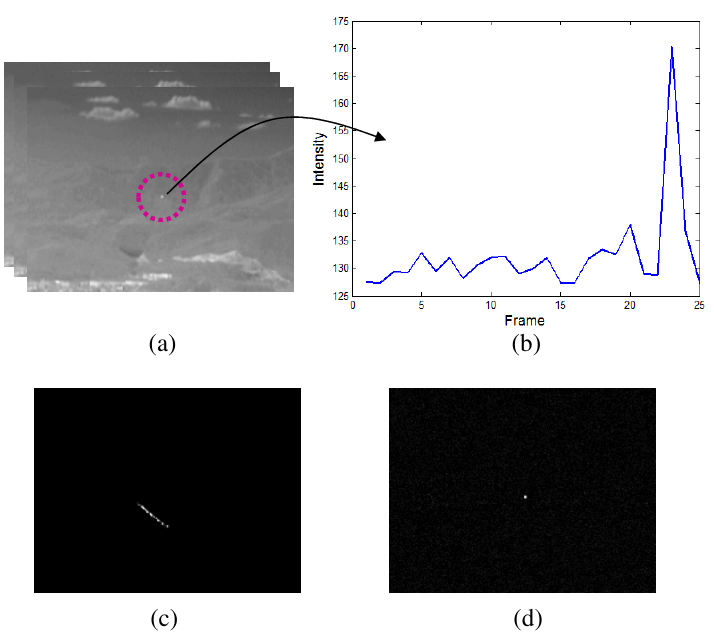
Figure 8. Basic concept of the temporal filter: ( a ) test sequence; ( b ) an example of temporal profile for a specific pixel; ( c ) temporal variance filter (TVF) result; and ( d ) temporal contrast filter (TCF) result.